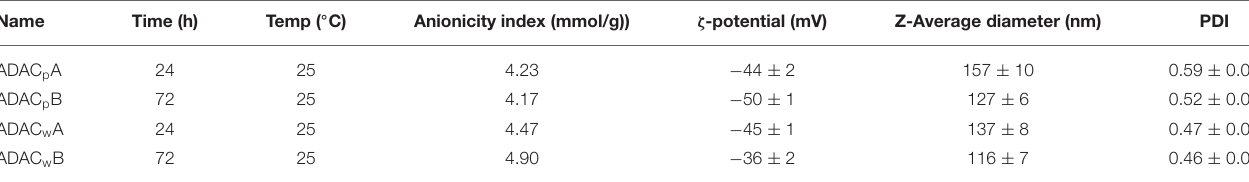
TABLE 2 | Anionization reaction conditions used for synthesis of anionic bio-PELs and characterization of final